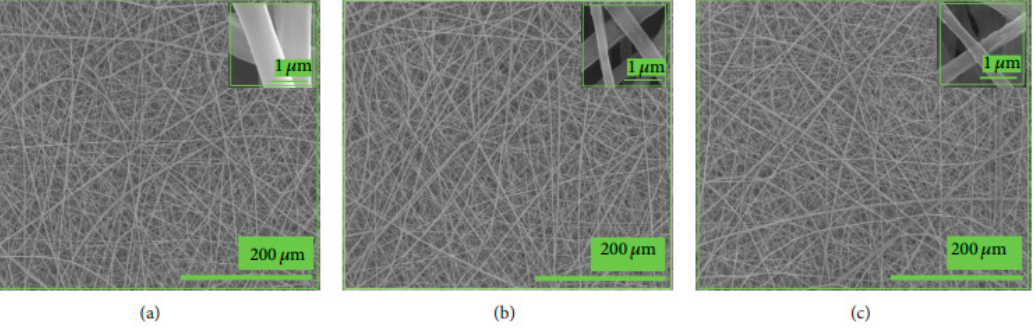
Figure 21. FE-SEM images of ( a ) pristine PLGA, ( b ) nHA/PLGA, and ( c ) BMP-g-nHA/PLGA nanofiber scaffolds [21].